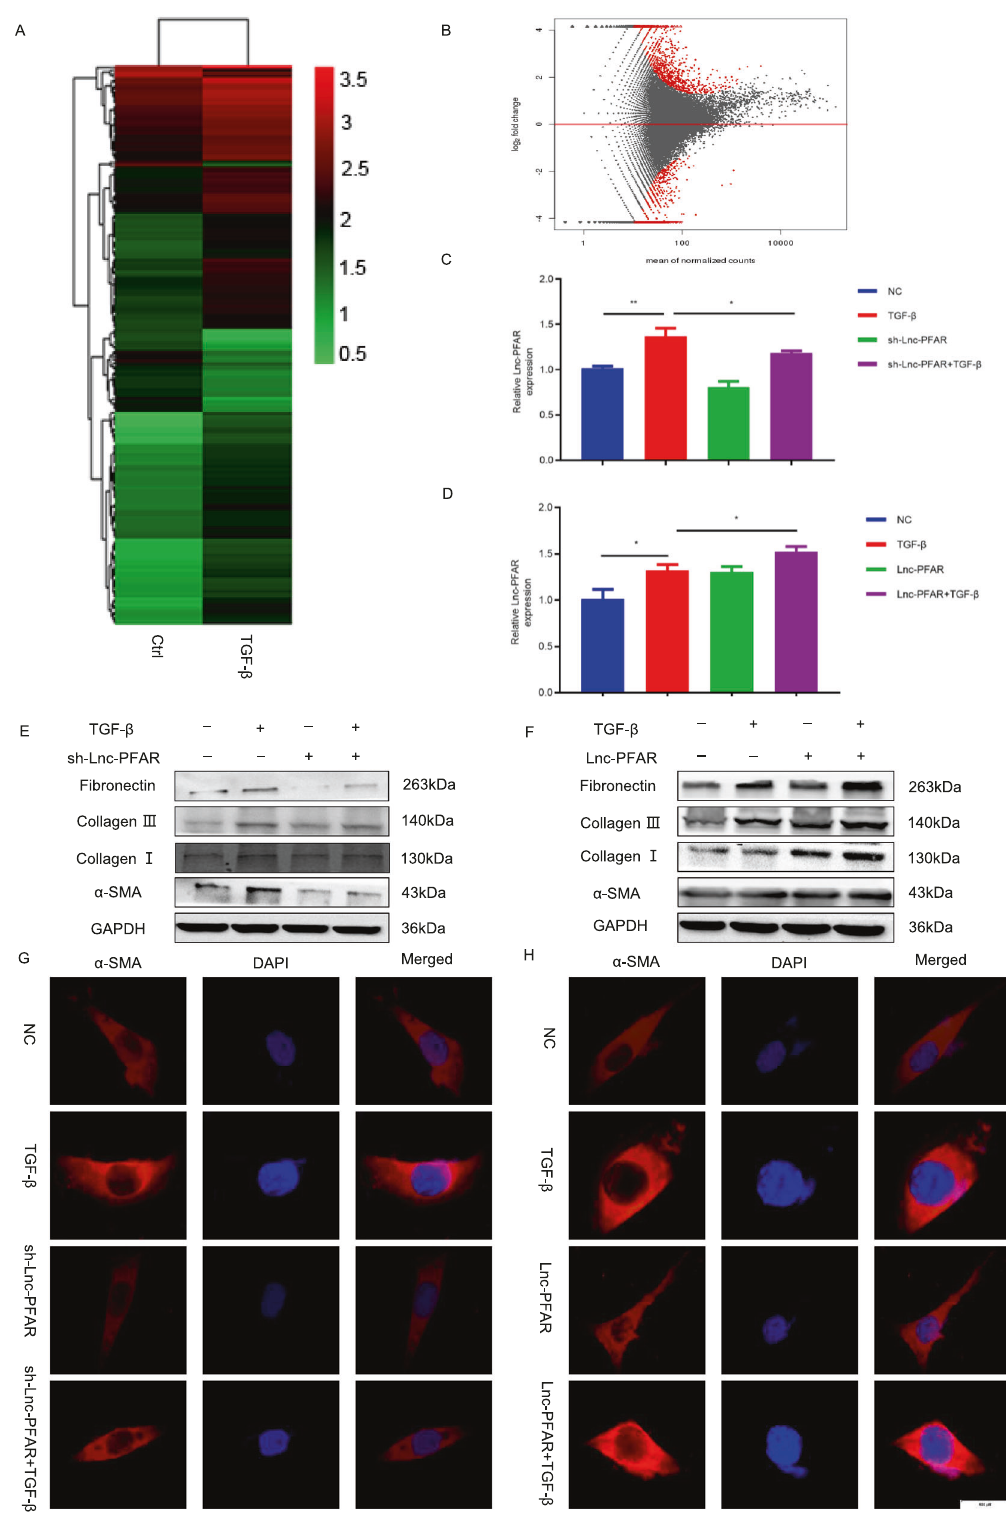
Fig. 1 Lnc-PFAR was veri fi ed as a novel lncRNA in PSCs activation. A , B The heatmap and volcano plots showed that 189 genes were changed in activated PSCs compared with quiescent PSCs (fold change ≥ 2 or ≤ 0.5, p ≤ 0.05). C , D The expressions of Lnc-PFAR were compared in TGF- β -treated PSCs in combination with Lnc-PFAR downregulation or upregulation. E , F The expression levels of α -SMA, Collagen I, Collagen III, and Fibronectin were tested in PSCs in which Lnc-PFAR is downregulated or upregulated. The relative expression represents the ratio of target to GAPDH. G , H The α -SMA expressions were explored in PSCs of quiescent, TGF- β -treated, sh-Lnc-PFAR, sh-Lnc-PFAR plus TGF- β , Lnc- PFAR-upregulated, and Lnc-PFAR plus TGF- β groups via immuno fl uorescence staining (bars, 500 μ m). The results are representative of three independent experiments (* p < 0.05 and ** p <